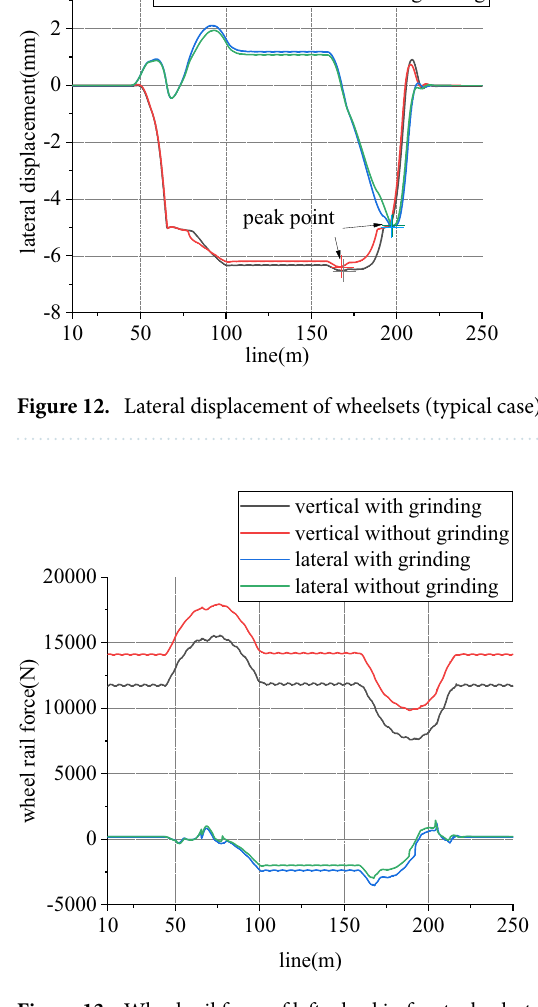
Figure 13. Wheel rail force of left wheel in front wheelset (typical case).